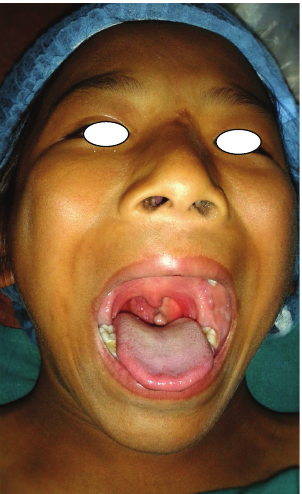
Figure 3: Excised (surgical) specimen.